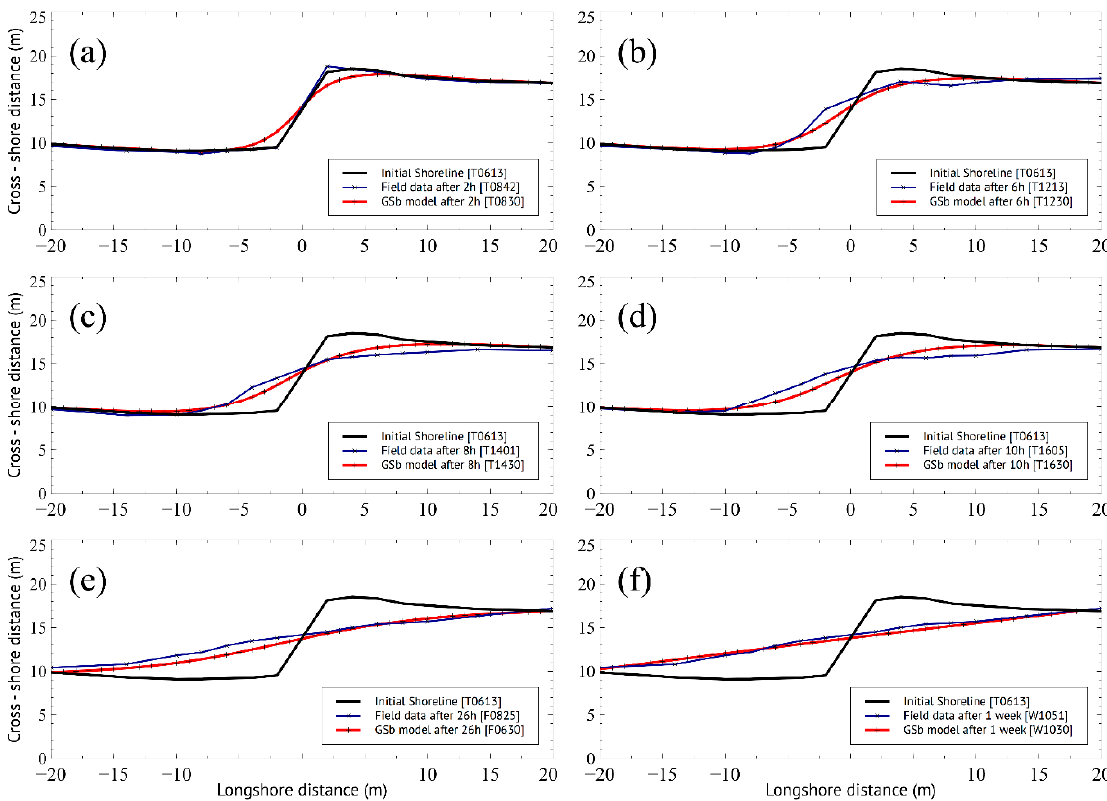
Figure 13. Measured and calculated shoreline position ( a ) 2 h, ( b ) 6 h, ( c ) 8 h, ( d ) 10 h, ( e ) 26 h and ( f ) 1 week after the structure removal. Information on the brackets indicates the corresponding weekday (T = Thursday, F = Friday) and local time of field data and GSb simulation.